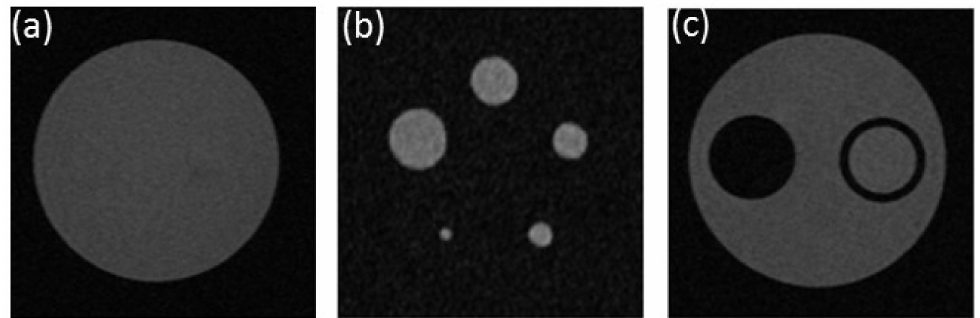
Figure 10. The MRI transverse images of NEMA standard IQ phantom. ( a ) The uniformity region, ( b ) five rods, and ( c ) two-chamber